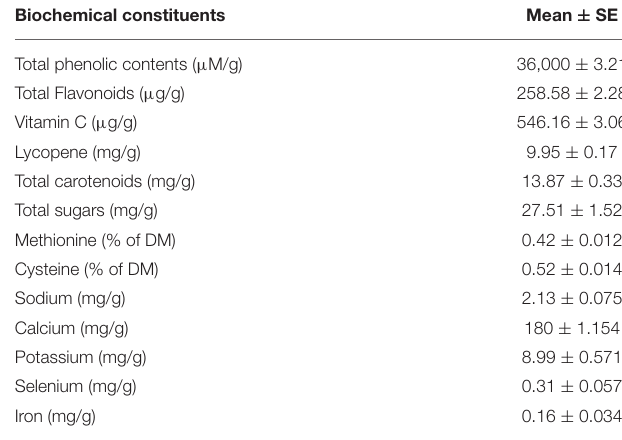
TABLE 1 | Formulation of basal diet (% DM). Ingredients